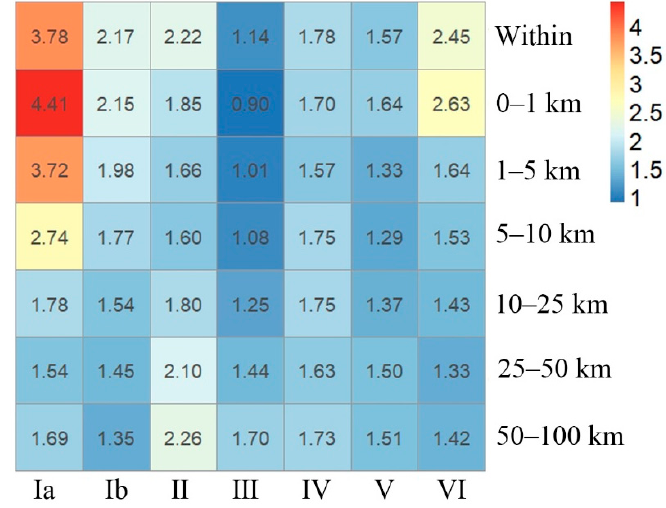
Figure 10. Growth rate of NTL within every type of PA and the buffer zones.